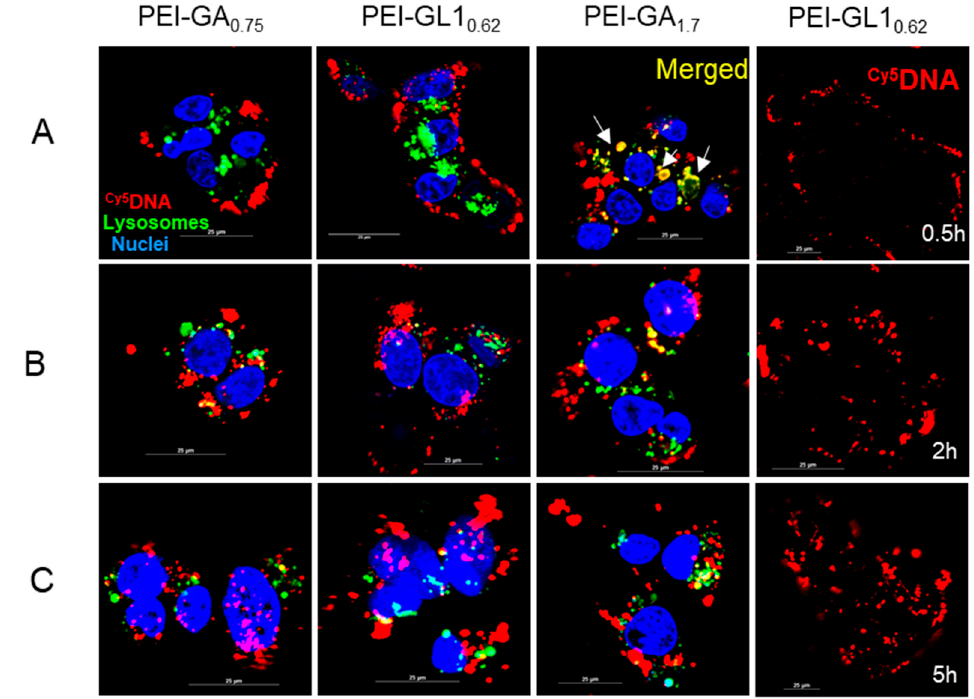
Figure 8. Confocal images of the three polyplexes. PEI-GL1 0.62 /pLUCI, PEI-GA 0.75 /pLUCI and PEI-GA 1.7 /pLUCI cultured for 0.5 h ( A ), 2 h ( B ) and 5 h ( C ) on HepG2 cells. The images were taken from Cy5-DNA (red), lysotracker green (green), Hoechst 33342 (blue) channels, Cy5 DNA dose was 0.35 μ g/mL. All scale bars represent 25 μ m.